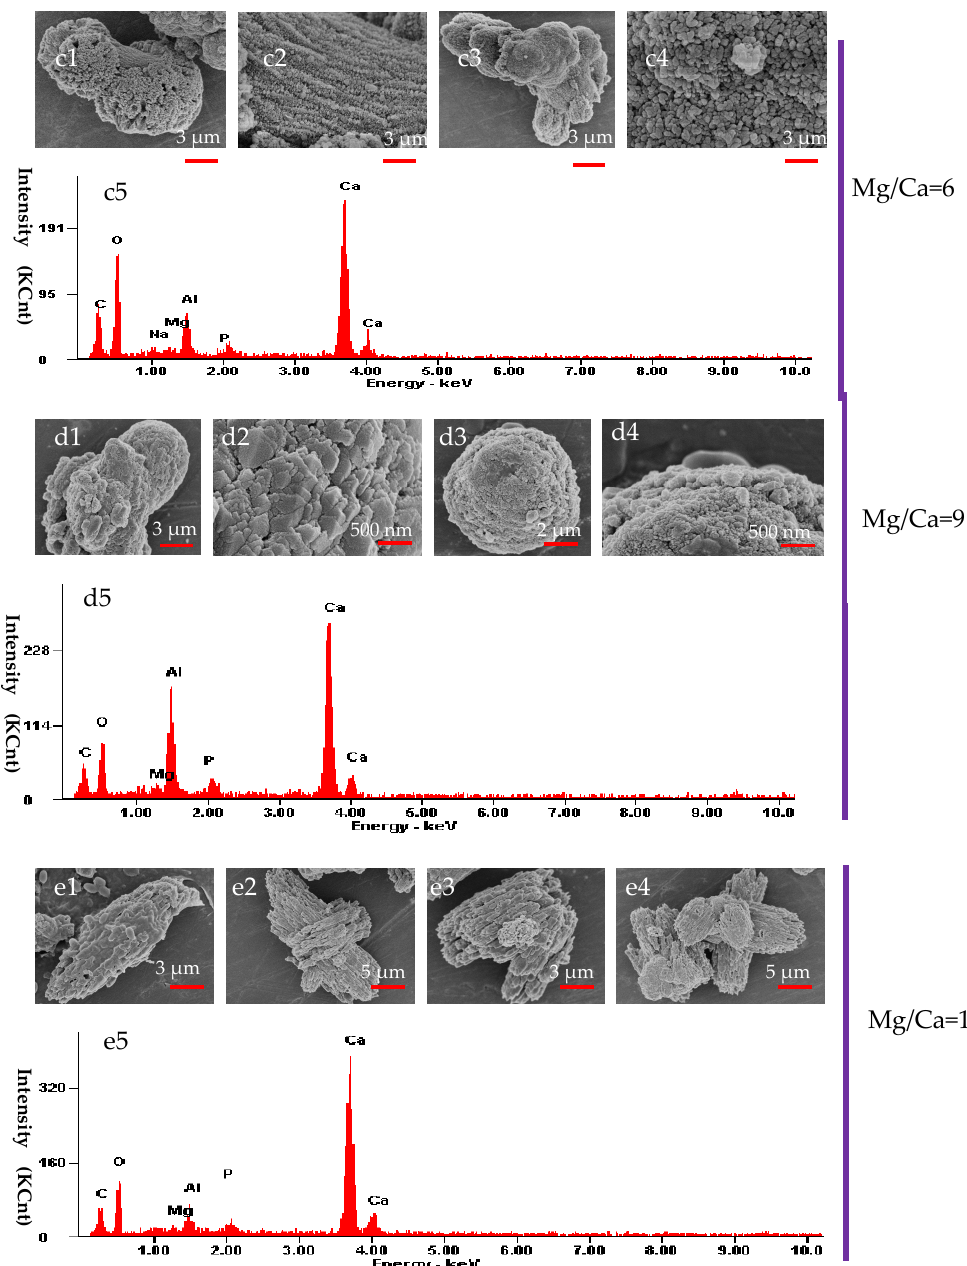
Figure 8. SEM and EDS analyses ( a 5 , b 5 , c 5 , d 5 , and e 5 ) of the minerals in the experimental group after 24 days of cultivation. Mg/Ca molar ratio of 0 ( a 1 – a 4 ); Mg/Ca molar ratio of 3 ( b 1 – b 4 ); Mg/Ca molar ratio of 6 ( c 1 – c 4 ); Mg/Ca molar ratio of 9 ( d 1 – d 4 ); Mg/Ca molar ratio of 12 ( e 1 – e 4 ).